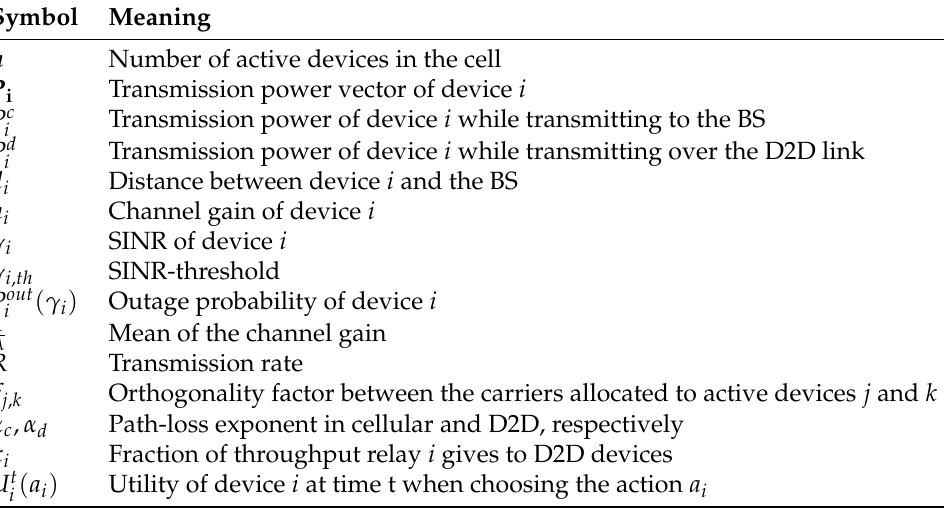
Figure 1. Cellular offloading using device-to-device (D2D) cooperative relaying. Table 1. Main symbols and their